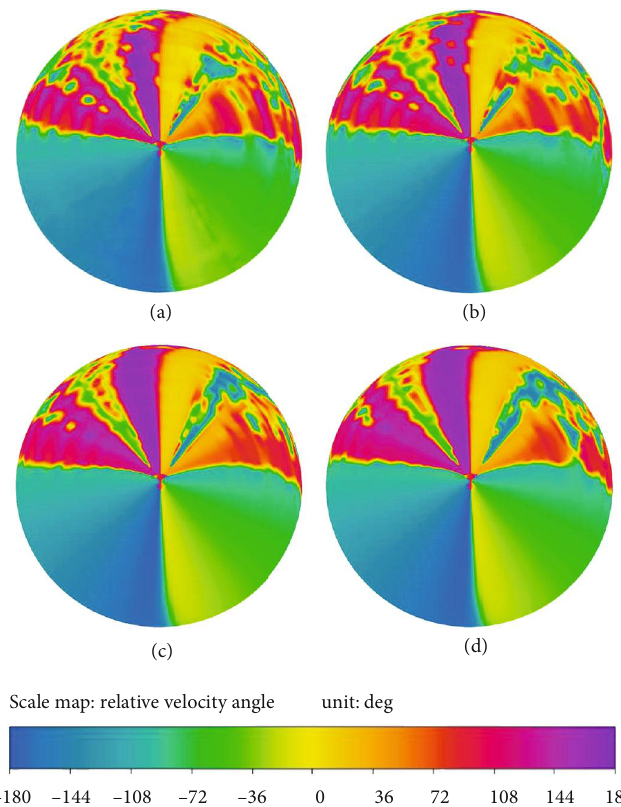
Figure 25: Comparison of surface relative velocity angle with di ff erent roughness values: (a) Model 1, (b) Model 2, (c) Model 3, and (d) Model